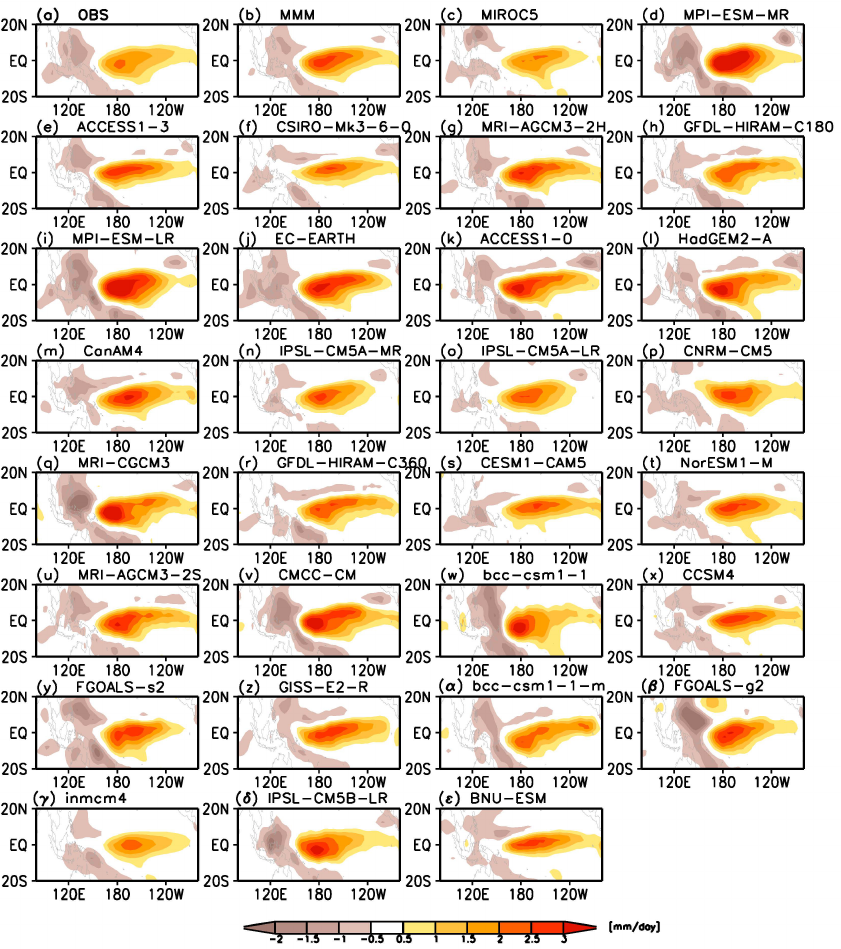
Figure 2. Regression coefficients of the PRCPA with respect to the normalized NINO3.4 SST index in the observations, MMM, and 29 models. ( a ) OBS; ( b ) MMM; ( c ) MIROC5; ( d )